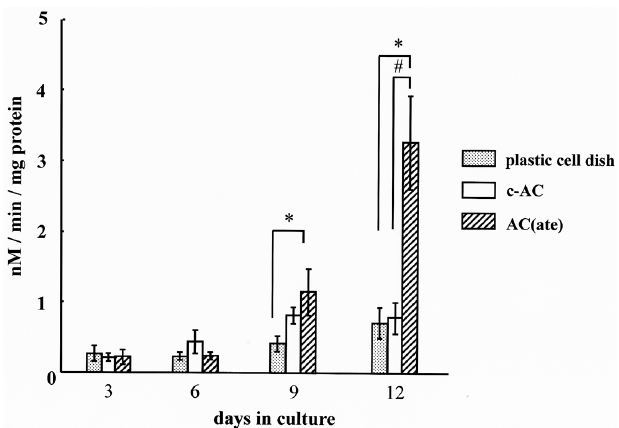
Figure 5. Time course of alkaline phosphatase (ALP) activity by MC3T3-E1 cells in cultures with each type of specimen. Results are shown as the mean ± standard deviation ( n = 5). * and # indicate a significant difference as compared to the plastic cell well and c-AC, respectively (Student’s t -test: p < 0.05).